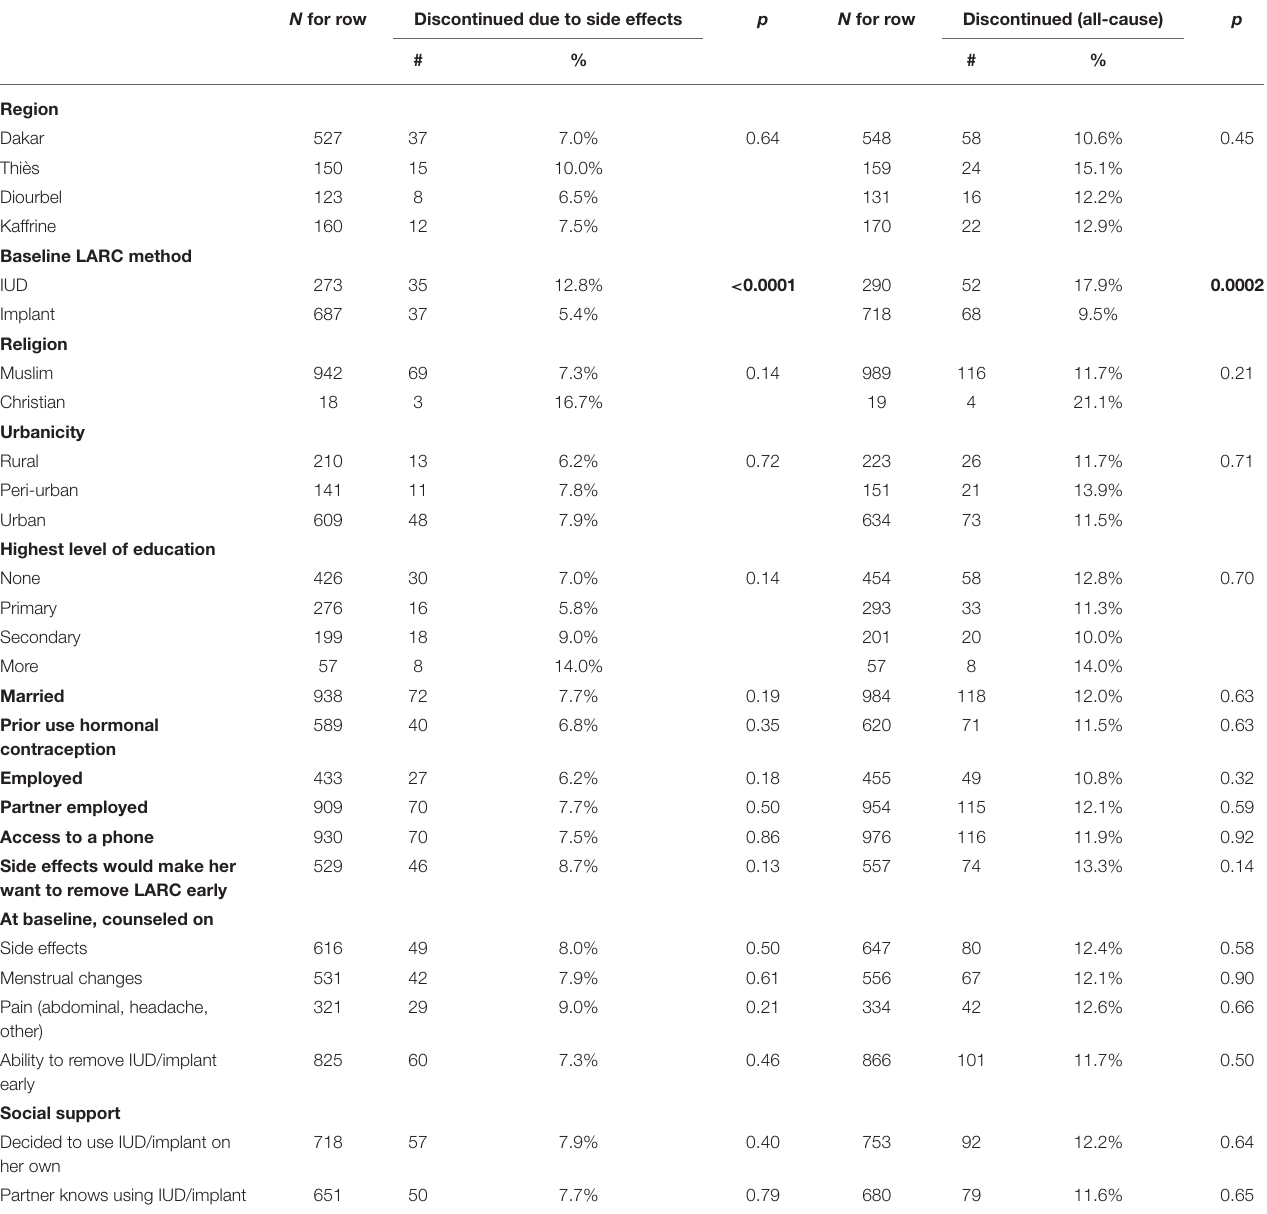
TABLE 2 | Bivariate associations between categorical variables of interest and discontinuation of baseline method by 12-months (due to side effects and all-cause). N for row Discontinued due to side effects p N for